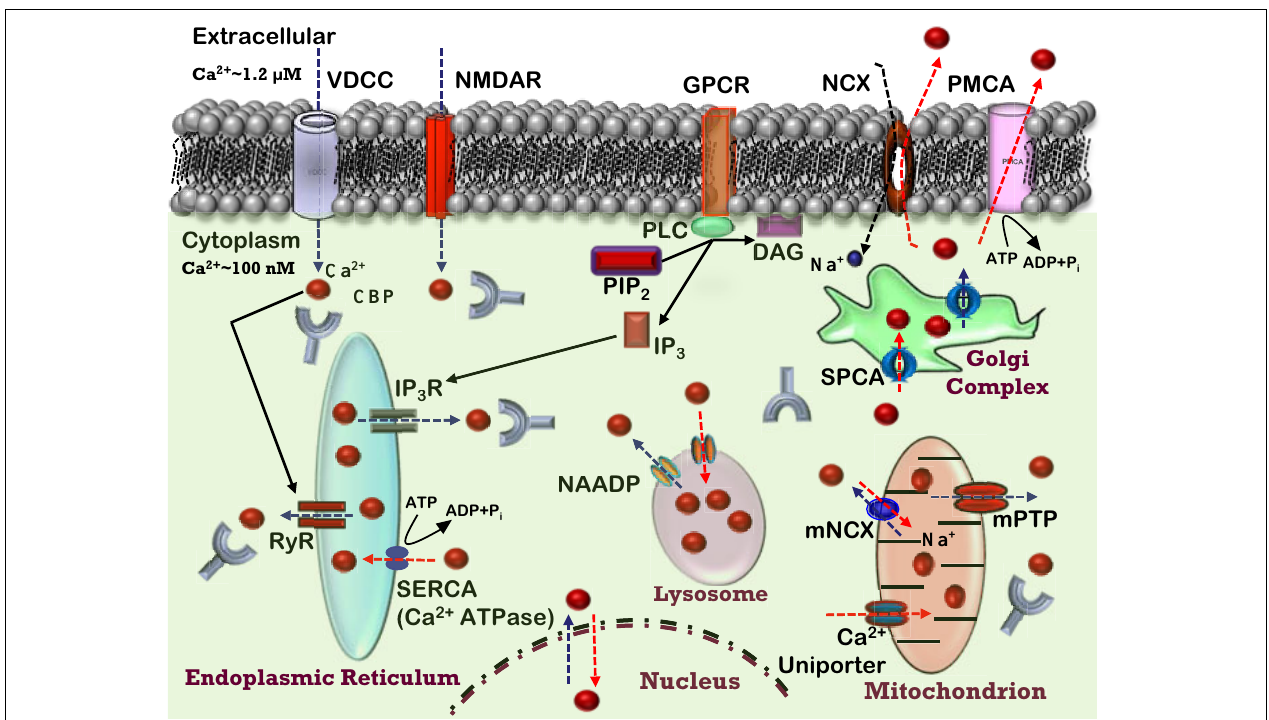
mitochondria, and lysosomes act as a Ca 2 + buffering system, releasing and FIGURE 1 | Ca 2 + homeostasis in the neuron. Model depicting various Ca 2 + sources, sequestrating, buffering mechanisms, and Ca 2 + signaling events in a sequestering Ca 2 + . Further, the model depicts Ca 2 + buffering and extrusion healthy neuron. Indicated are the voltage-dependent Ca 2 + channels ( VDCC ), N - pathways ( red dashed arrows ), involving Na + /Ca 2 + exchanger ( NCX ) and plasma methyl- D -aspartate receptor ( NMDAR ), and G protein-coupled receptor ( GPCR ) membrane Ca 2 + ATPase ( PMCA ), sarcoplasmic reticulum Ca 2 + ATPases ( SERCA ), involved in Ca 2 + ( red balls ) infl ux into the cytosol ( blue dashed arrows ). The nicotinic acid adenine dinucleotide phosphate ( NAADP ), various Ca 2 + binding release of Ca 2 + into the cytoplasm also occurs from the intracellular Ca 2 + stores proteins ( CBP ). Mitochondrial permeability transition pore ( mPTP ) and mitochondrial Na + /Ca 2 + exchanger ( mNCX ) and secretory pathway Ca 2 + -ATPases ( ICS ) through inositol (1,4,5)-trisphosphate receptor ( IP R ) and ryanodine 3 receptors ( RyR ). Organelles, including the endoplasmic reticulum ( ER ), ( SPCA ) contribute to Ca 2 +